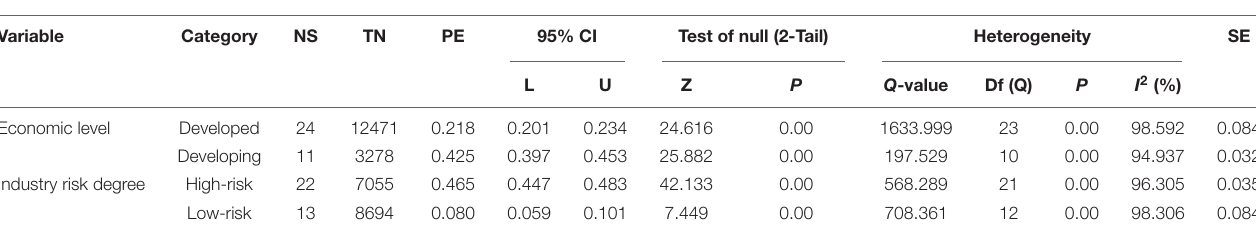
TABLE 7 | Results of moderators with subgroup